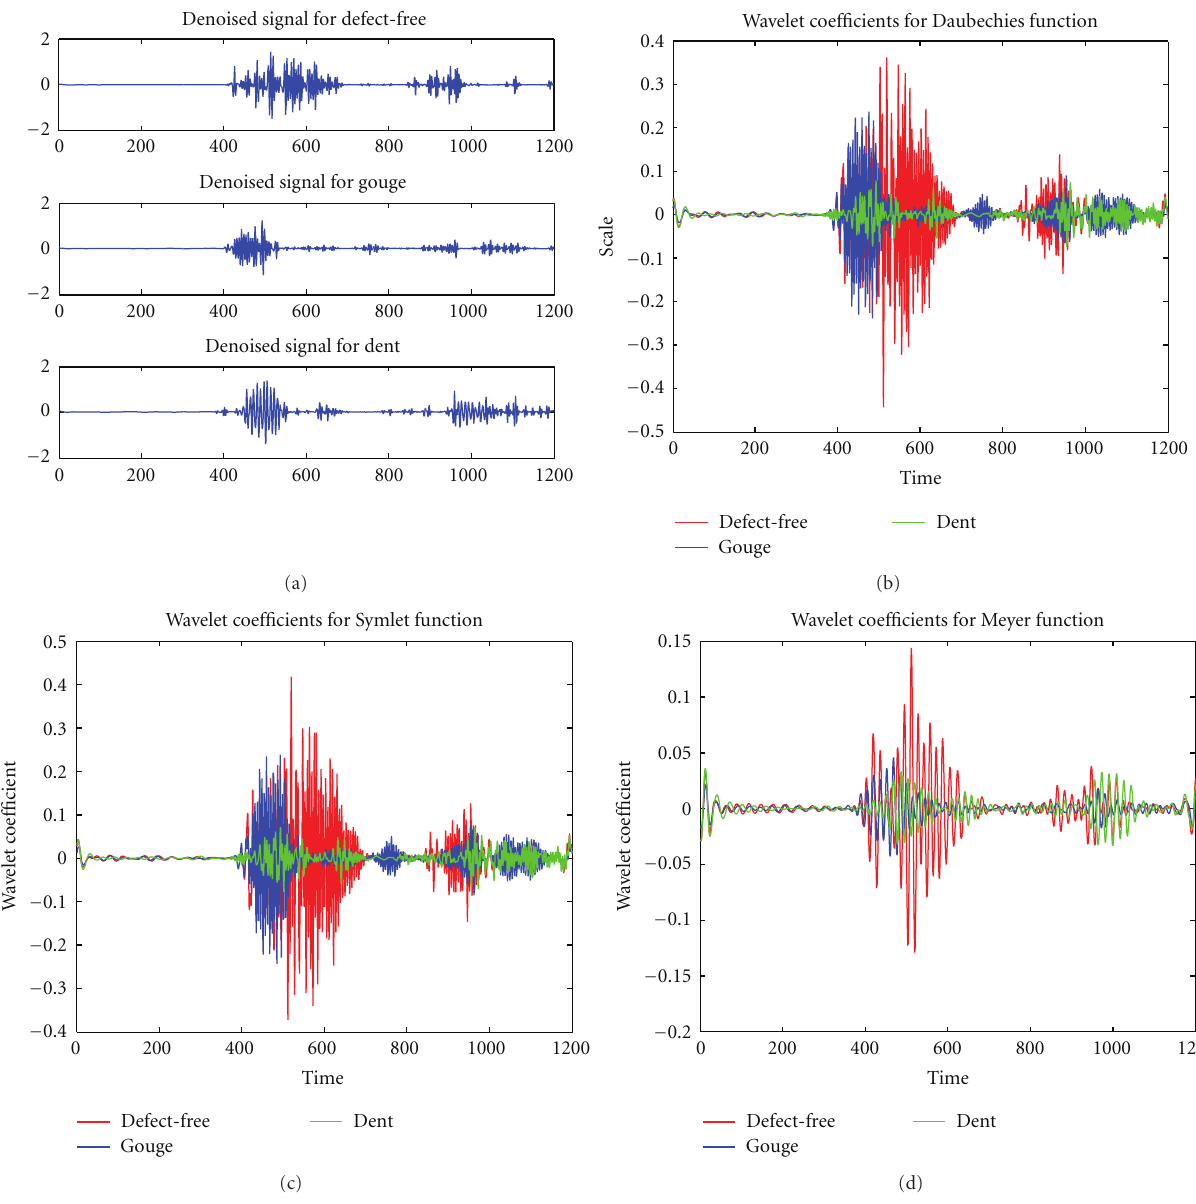
Figure 8: (a) denoised signals for defect-free, gouged, and dent pipes. Continuous wavelet transforms for defect-free, gouged and dented pipes under traction-free boundary conditions, (b) for Daubechies (db4) function, (c) for Symlet (sym4) function, and (d) for Meyer